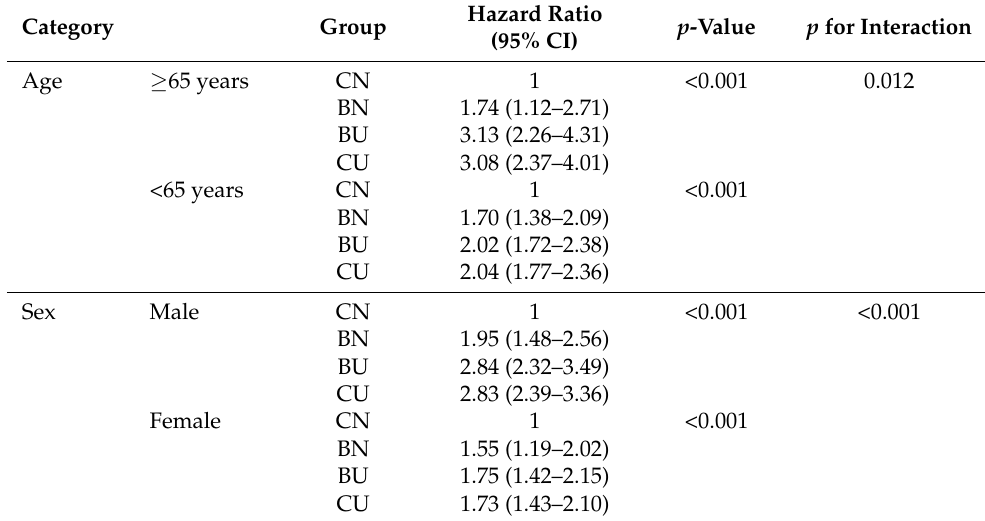
Table 3. Results of the subgroup analysis of hip fracture risk according to age and sex. Hazard Category Group